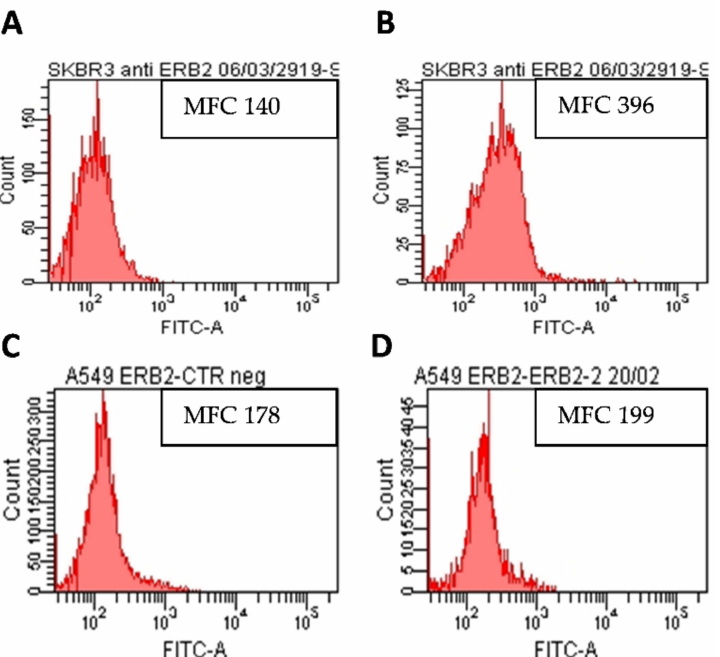
Figure 1. Flow cytometric analysis of HER2 expression in SKBR3 ( A , B ) and A549 cells ( C , D ). His- tograms from negative controls ( A , C ) and Ab-labelled cells ( B , D ) from a representative experiment are shown. The value of the mean fluorescence channel (MFC) is reported inside each